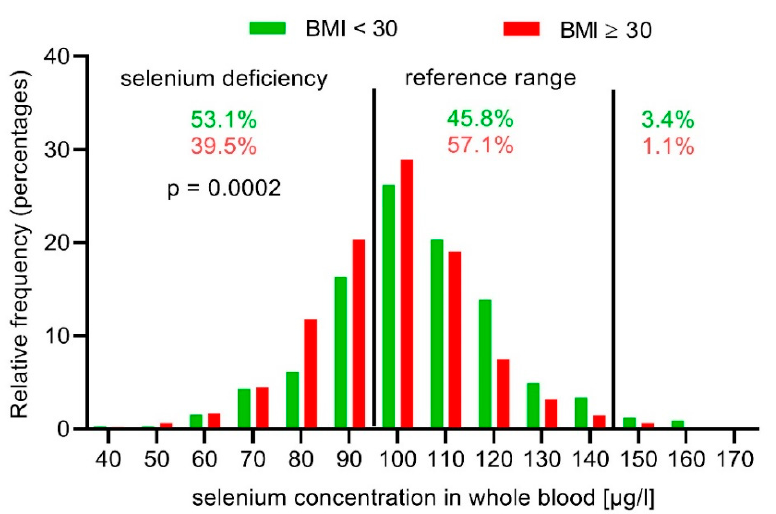
Figure 3. Selenium concentration in whole blood in obese lymphedema, Lipo-lymphedema, and lipedema patients (BMI ≥ 30), compared to normal and overweight patients (BMI < 30).